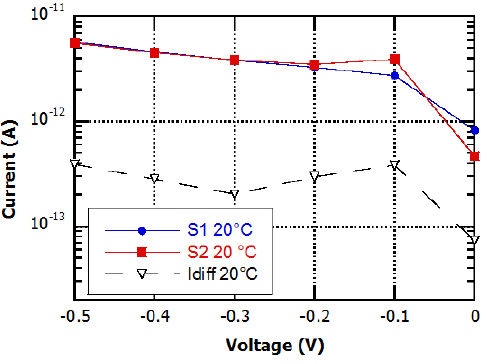
Figure 6. Current-voltage curves of the single diodes of the device and of the differential current measured in dark conditions at room temperature.